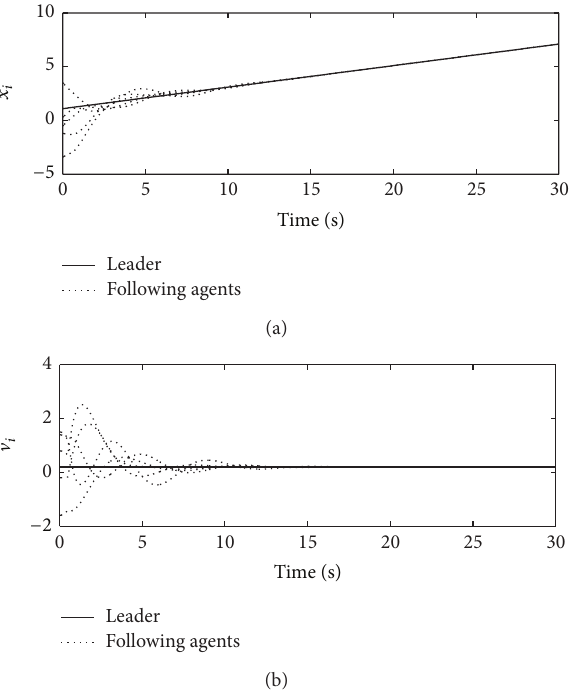
Figure 2: Delay-independent dynamical consensus under a span- ning tree.